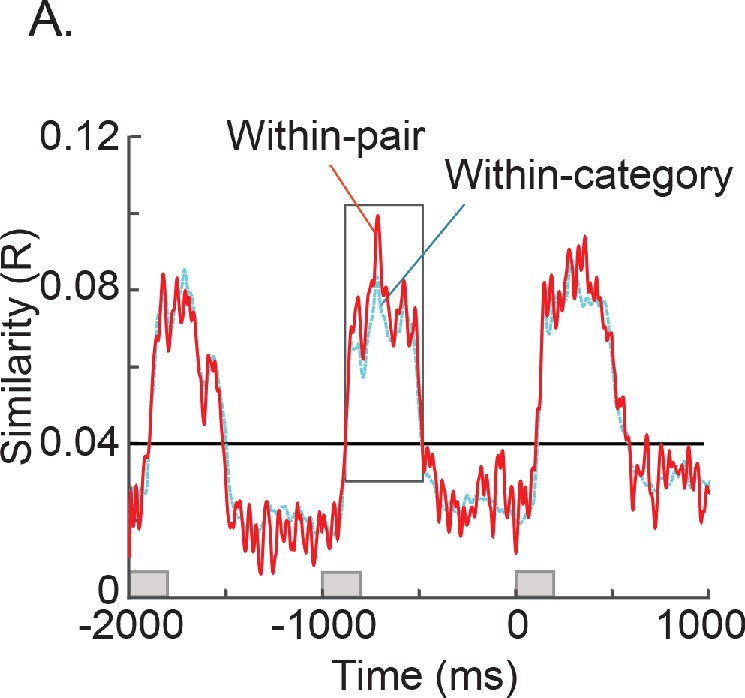
Results of the Spatial Representational Similarity Analysis for pairs in which the same word was predicted (within-pair, shown in red) and in which the same syntactic category (e.g. nouns or verbs) of words (but not the same words) was predicted (within-category, shown in cyan).The spatial similarity was greater when the same word was predicted than when different words belonging to the same syntactic category were predicted: t(25) = 3.559, p = 0.002. This suggests that the high within-pair spatial similarity relates to the specific representation of the predicted words over and above the syntactic category that the predicated words belong to.